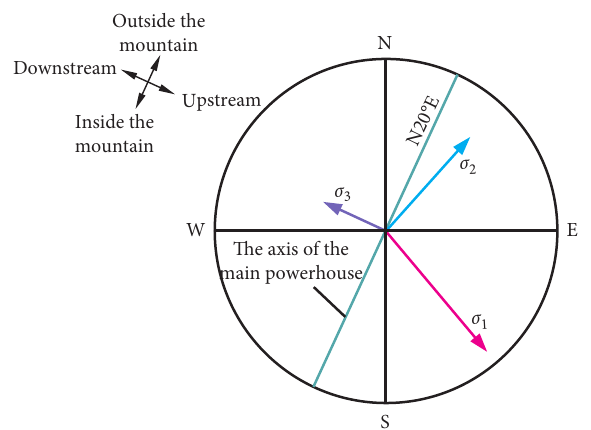
Figure 3: Schematic diagram of the initial in situ stresses of the left bank underground